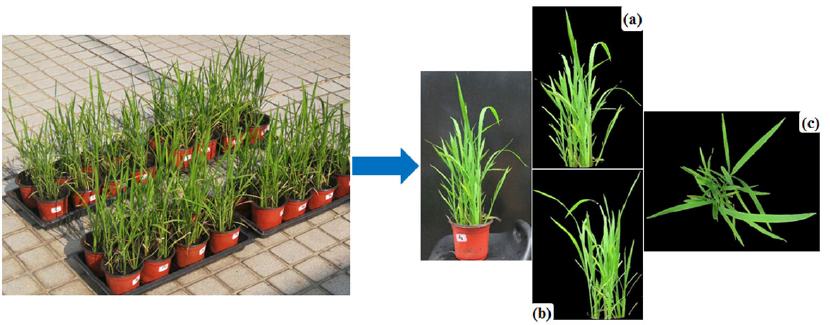
Figure 2. Experimental rice samples and three sections for each potted rice plant obtained by